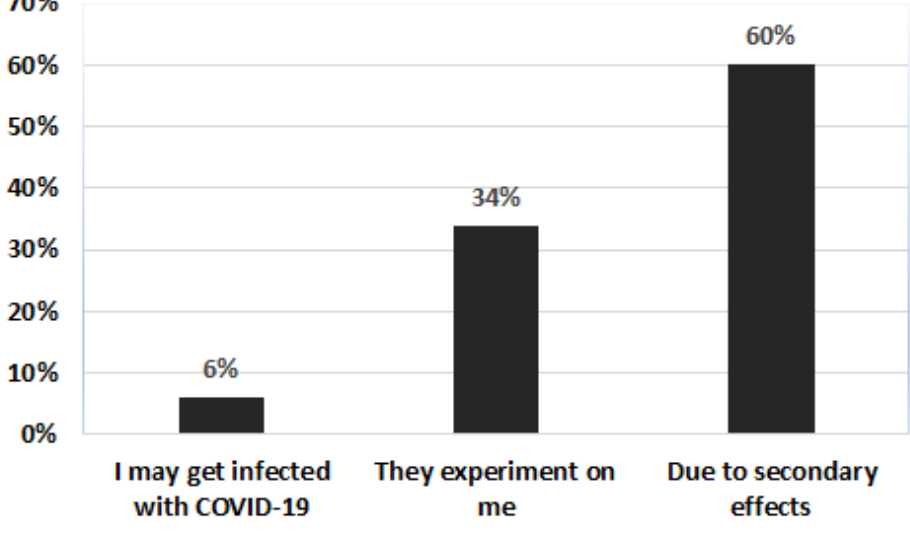
Figure 2. Geographical distribution of people that are hesitant or do not plant to get vaccinated in Peru.